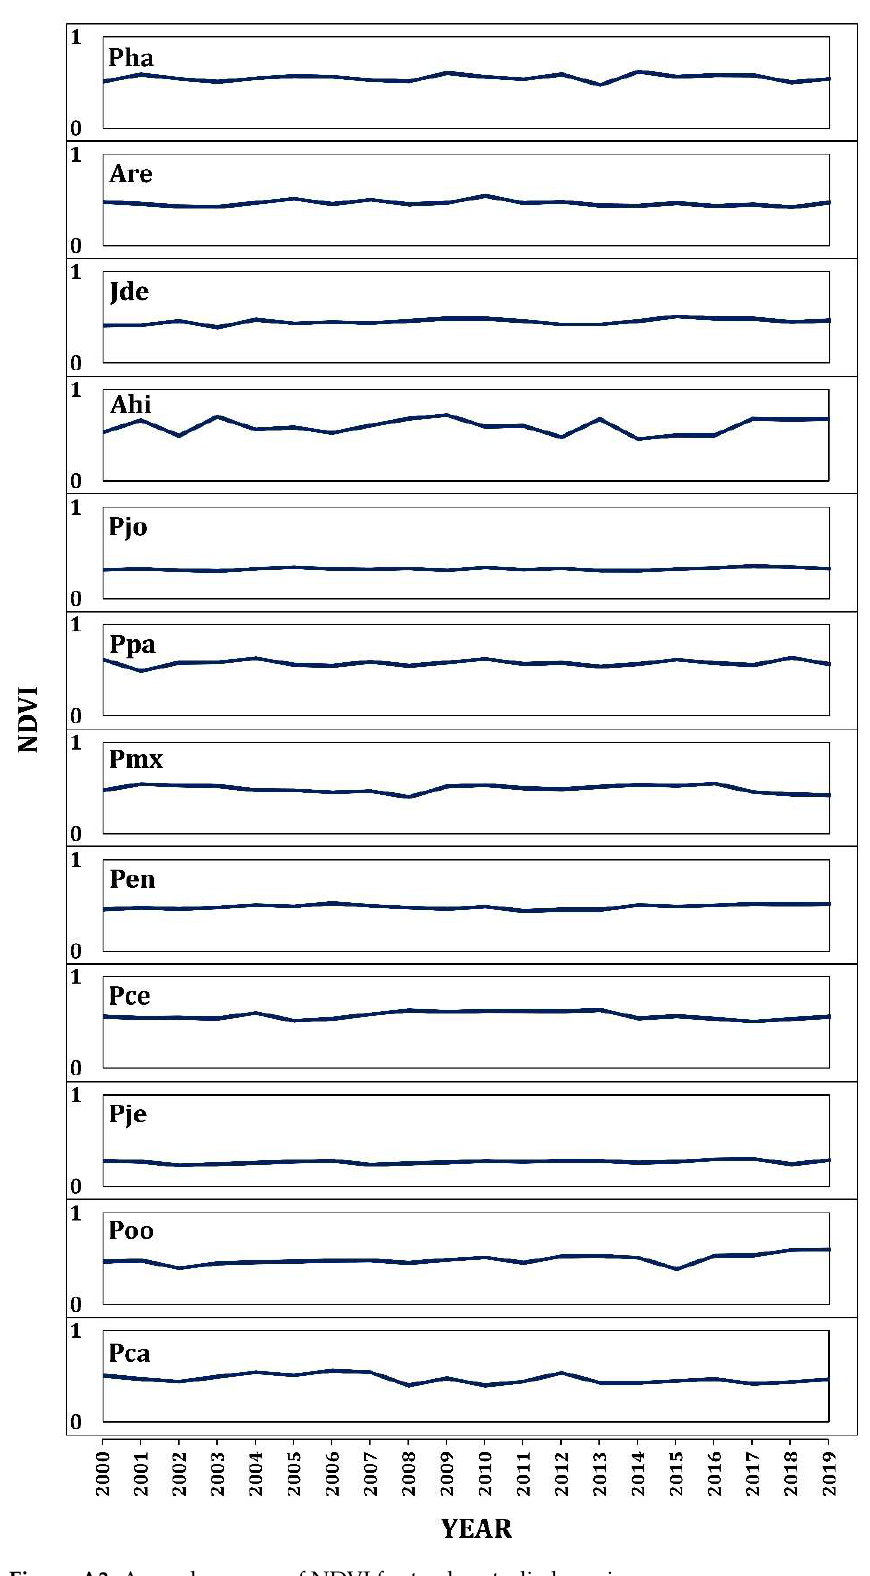
Figure A3. Annual average of NDVI for twelve studied species.